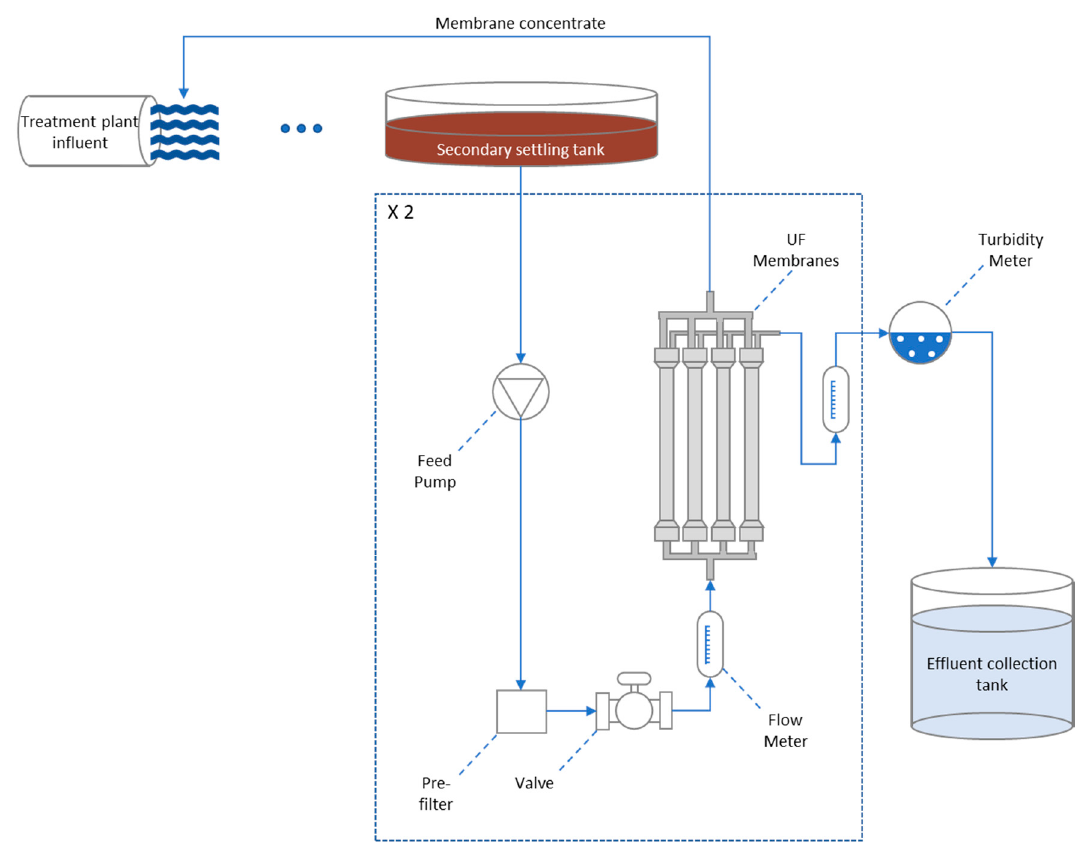
Figure 1. Membrane unit setup schematic. Table 2. Technical specifications of installed equipment.